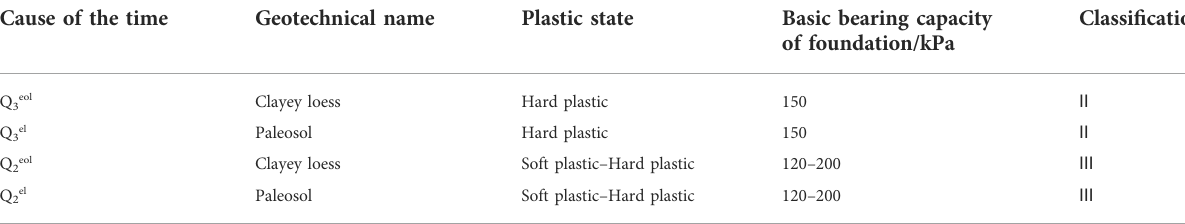
TABLE 1 Mechanical parameters of the ground